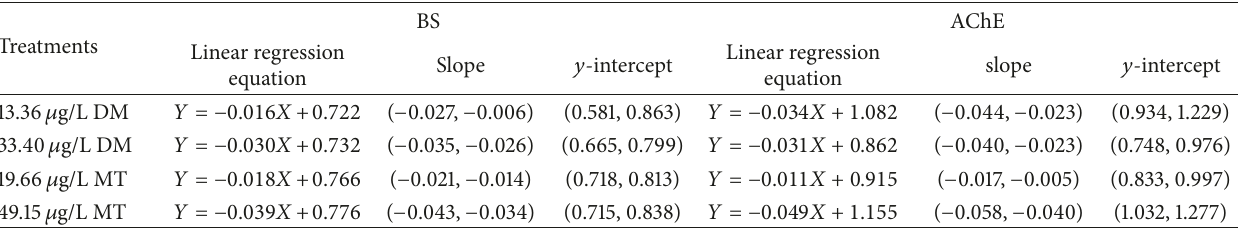
Table2:Linearregressionanalysisofbothwhole-bodyAChEactivity(%ofcontrol)andbehaviorstrengthof D.magna indifferenttreatments with 95% confidence